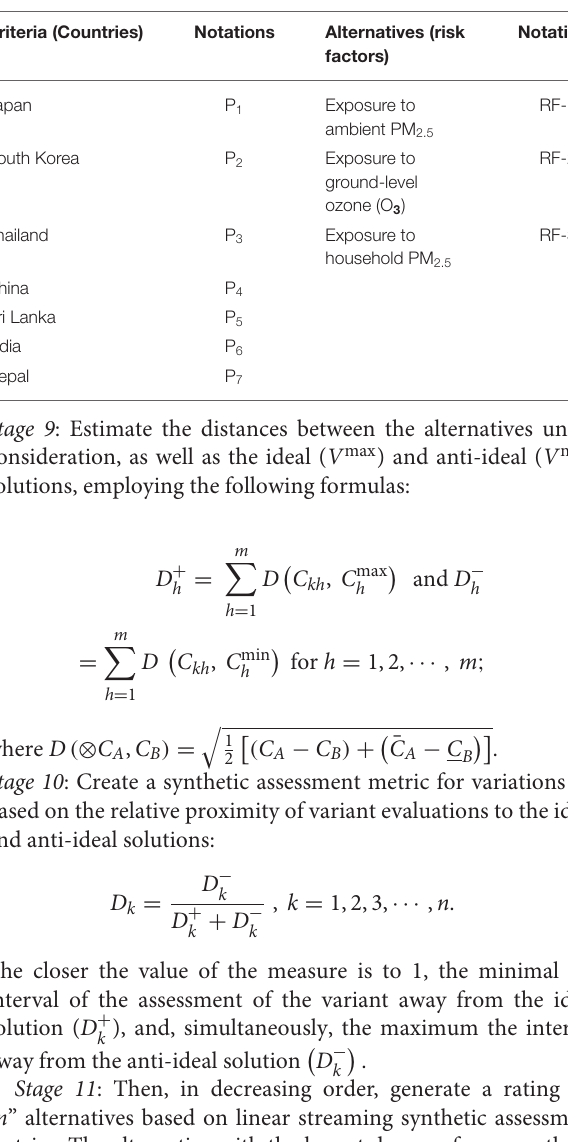
TABLE 4 | Definition of the decision